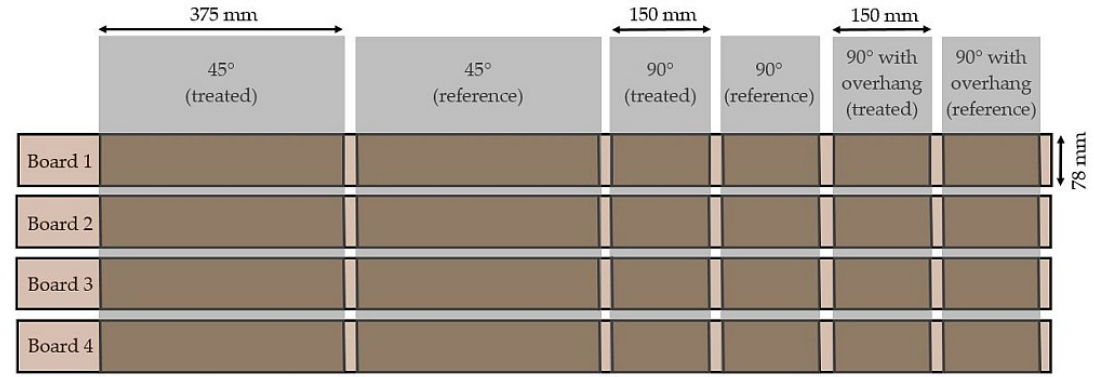
Figure 1. Preparation of the iron (II) sulfate-treated specimens and untreated specimens (reference) of sample set 3 from 4 boards for the exposure at 45°, 90°, and 90° with roof overhang.